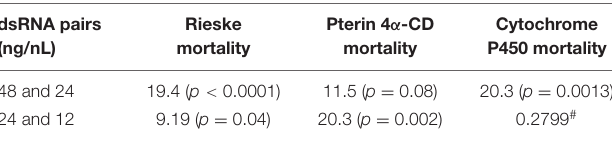
TABLE 3 | Comparison of different dsRNA concentrations by 2-way ANOVA with Fisher’s LSD test for the three best dsRNA diets showing dose response ( Figure 1B ).